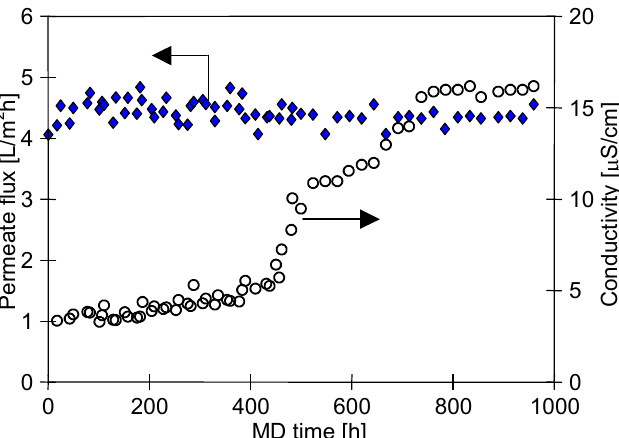
Figure 13. The changes of permeate flux and distillate conductivity during brackish water desalination. T F = 318 K. Module MK2—K1800.